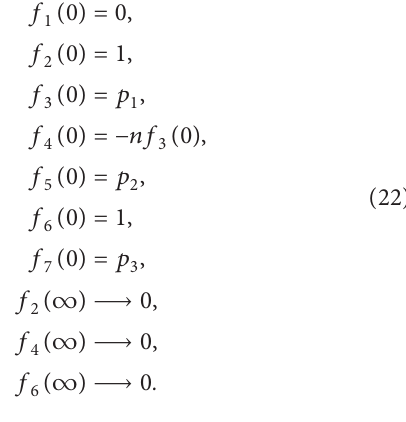
Table 2: Comparison of values of C ⋆ f with Kumar [49] and Tripathy et al. [50] for variation in K, M , and Da when n � 0 . 5.